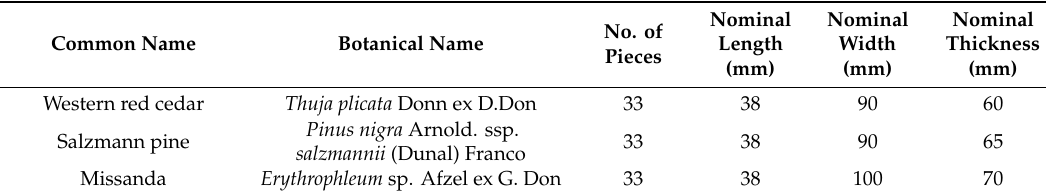
Table 1. Species and specimens’ nominal dimensions.